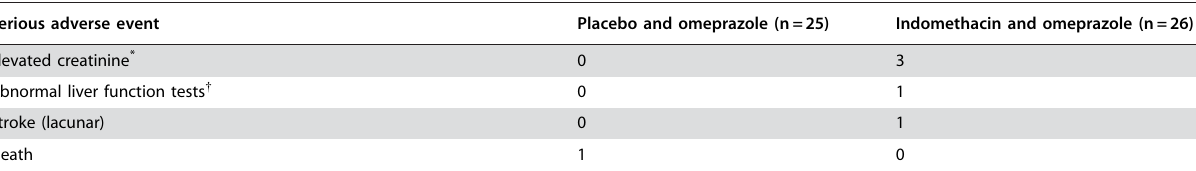
Serious adverse event Placebo and omeprazole (n=25) Indomethacin and omeprazole (n=26) Elevated creatinine * 0 3 Abnormal liver function tests { 0 1 Stroke